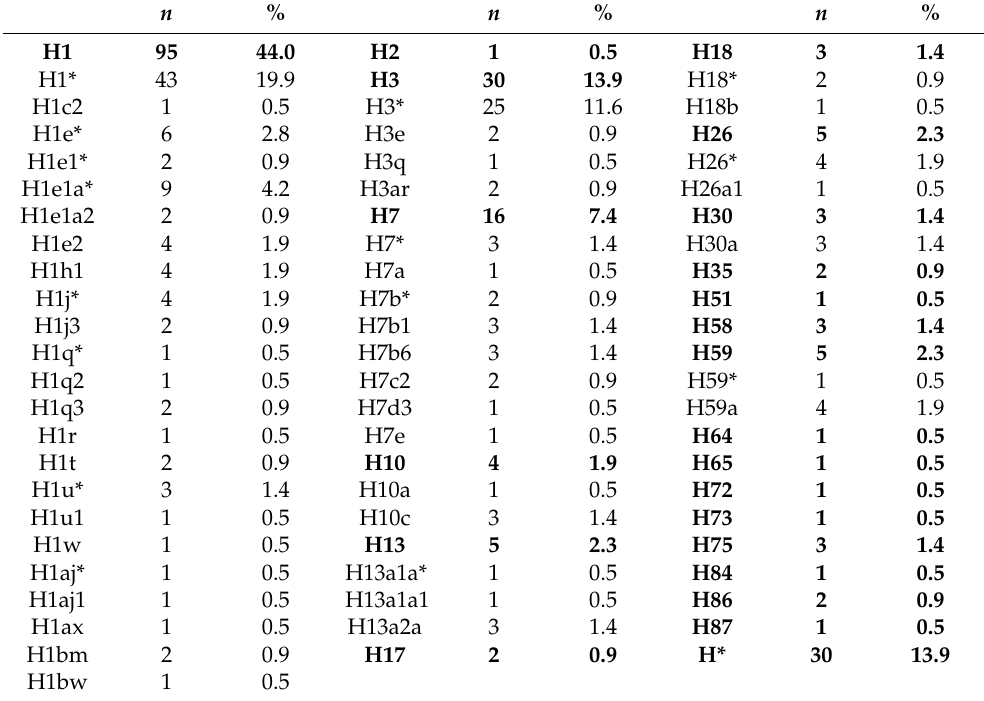
Table 2. Complete list of mtDNA haplogroups found in the 216 most common West Eurasian CR haplotypes at the complete mitogenome level. Bold text indicates first-level subhaplogroups. They comprise any listed subclades. Percentages are